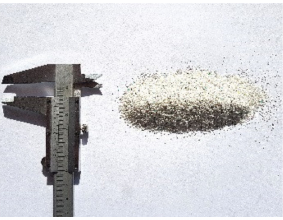
Figure 2. Medium-weight coarse-grained abrasive fraction.